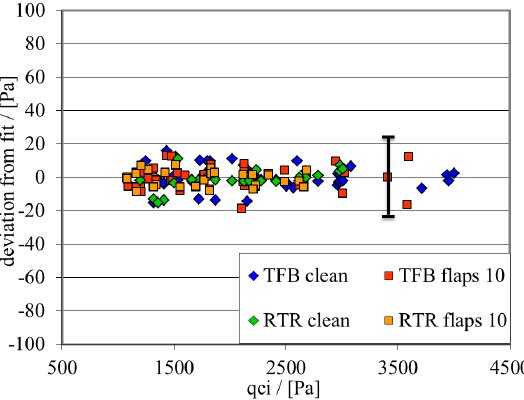
Figure 4. Results of the pitot-static calibration: deviation of the static source error ( (cid:49)p s ) of the third-order polynomial fit for all tower-flyby (TFB) and racetrack (RTR) flight points. The black er- ror bar represents the estimated overall accuracy of the static pres- sure measurement ( σ ∼